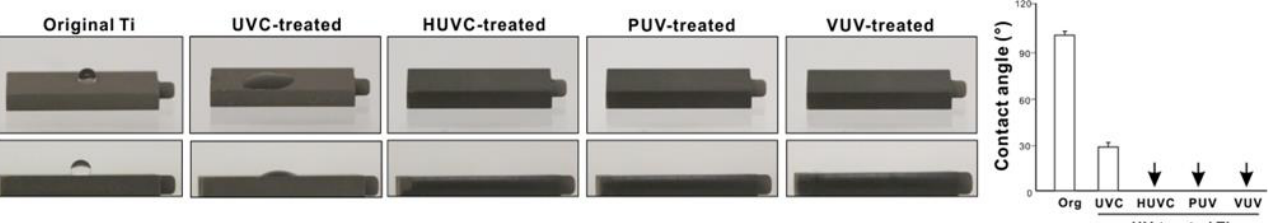
Figure 2. Hydrophilic/hydrophobic state of acid-etched microroughened titanium surfaces before and after UV treatment exposed to four different UV light sources for one minute: UVC from a low-pressure mercury lamp (UVC); high-energy UVC (HUVC); a UV device with a proprietary protocol (PUV); and 172 nm vacuum UV (VUV). Birds-eye and side-view photographs of a 3 µ L drop of ddH 2 O placed on microroughened titanium specimens, and a histogram showing contact angle measurements. Arrows indicate 0 ◦ .